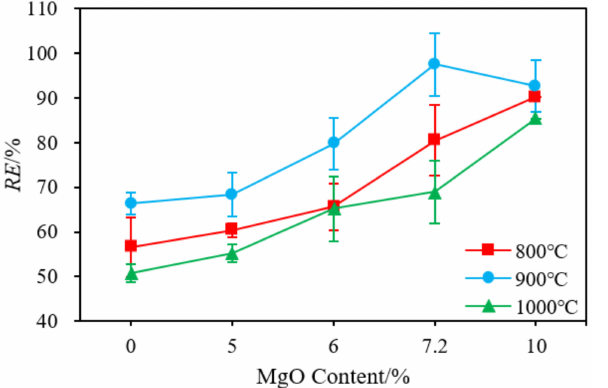
Figure 6. Improvement of MgO on phosphorous RE in ash of SS during SS combustion with 5% extra H 2 O.